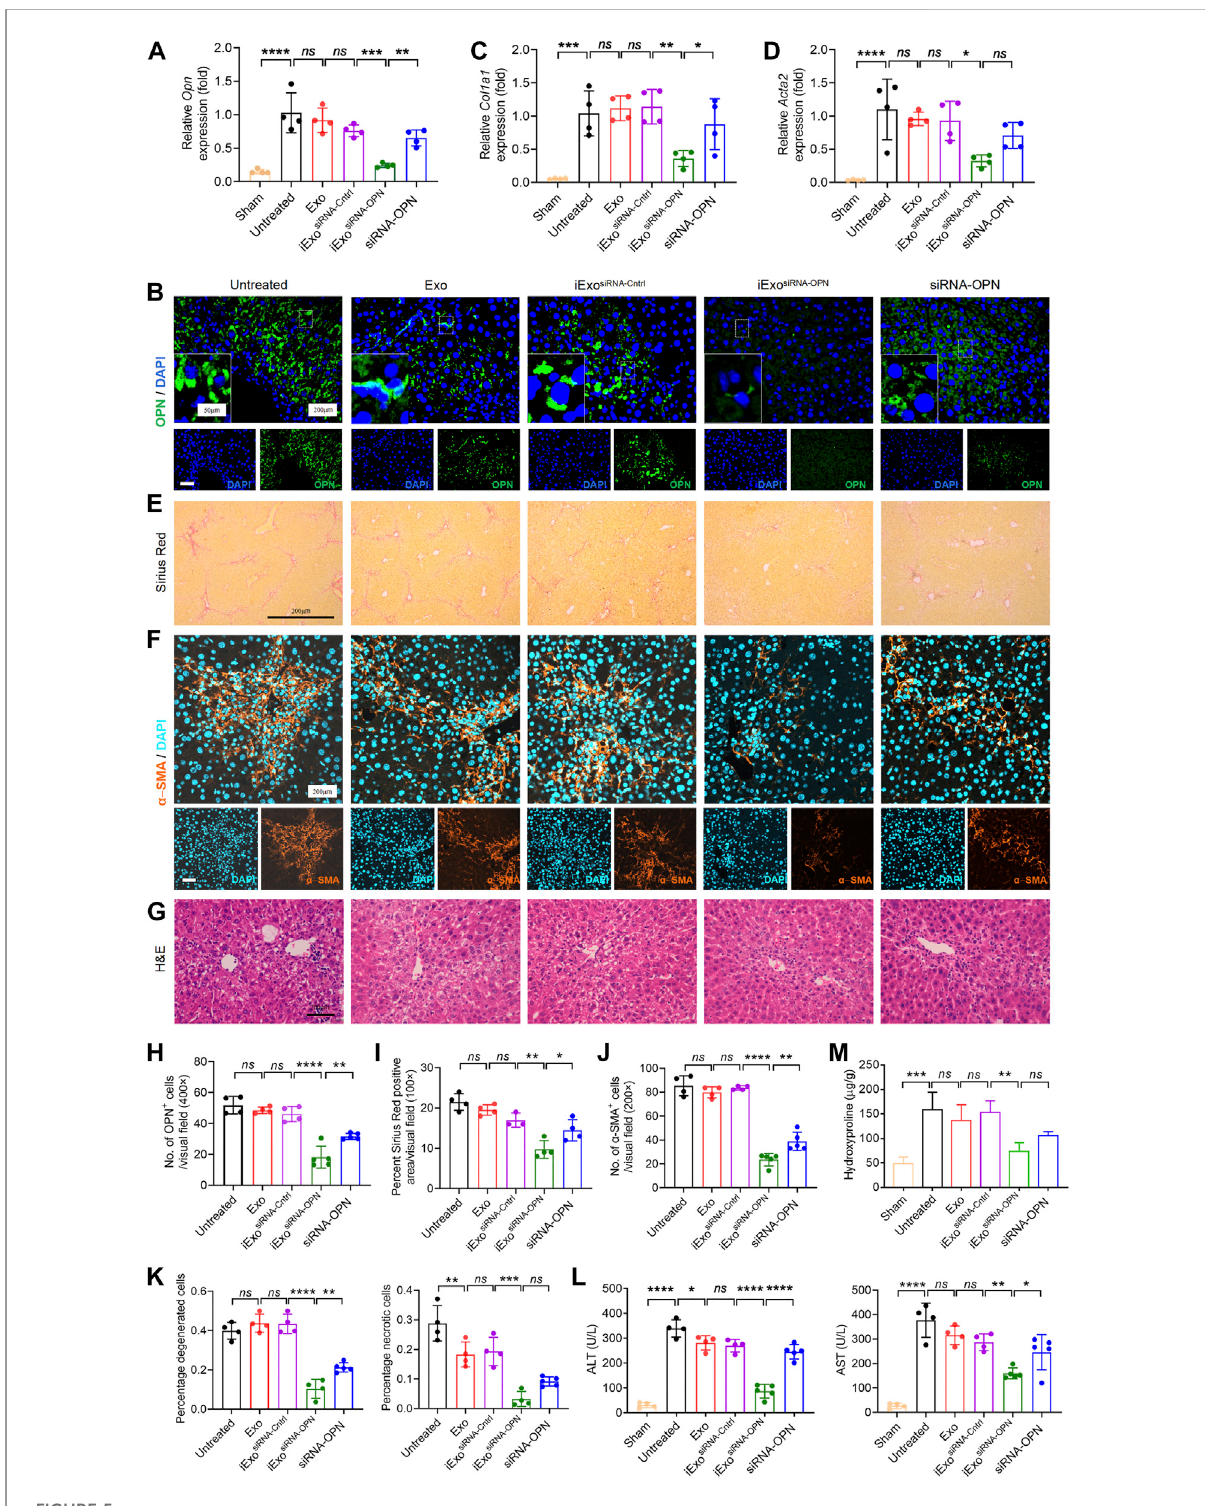
FIGURE 5 iExosomes targeting OPN inhibit liver fi brosis in vivo . (A,B,H) Relative Opn expression analyed by qPCR analysis (A) and IF staining (B) . (H) The average number of OPN positive cells in each visual fi eld. Untreated, Exo, and iExo siRNA − Cntrl : n = 4 mice per group; iExo siRNA − OPN , siRNA-OPN: n = 5 mice per group. Scale bar: 200 μ m (inserted scale bar: 50 μ m). (C,D) Col1a1 (C) and Acta2 (D) expression by qPCR analysis in liver from mice subjected to exosomes electroporatedwithsiRNAornakesiRNA. n =4micepergroup. (E,I) Siriusredstaining (E) oflistedliversections. (I) Percentage of sirius red